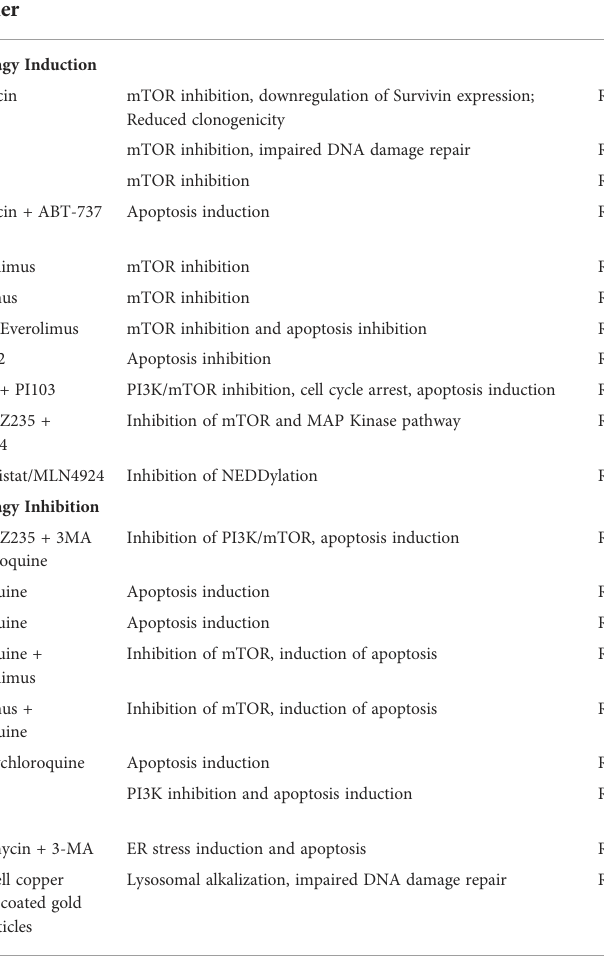
Autophagic modulators, generating radioresistance are indicated in red highlighted